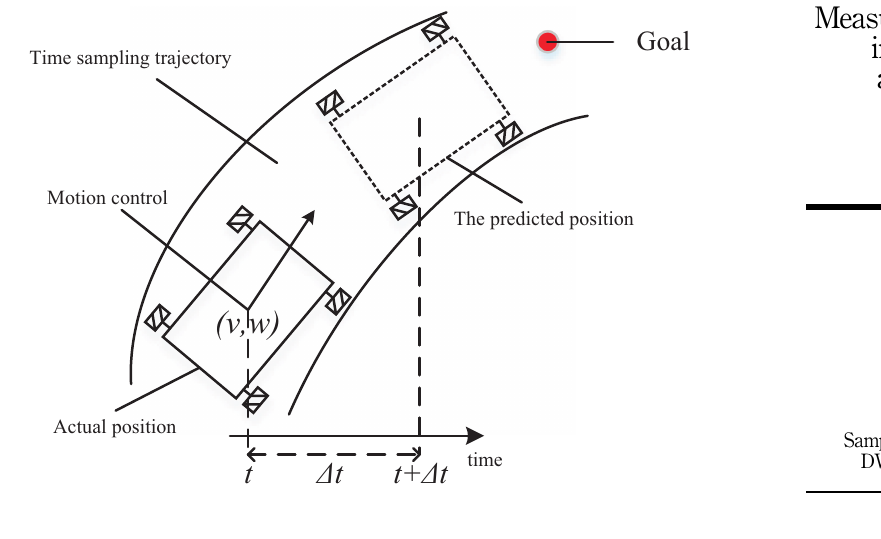
Figure 6. Sampling space of DWA